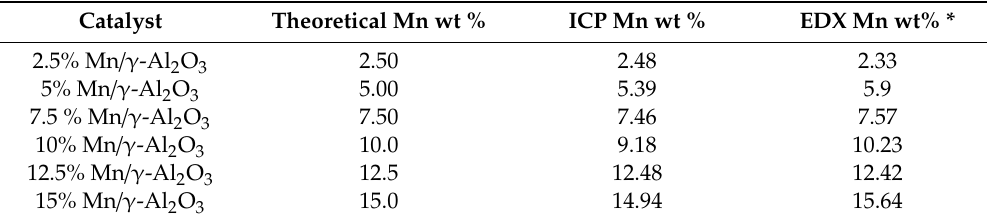
Table 1. Inductively coupled plasma (ICP) and energy dispersed X-Ray spectroscopy (EDX) results of Mn/γ-Al 2 O 3 catalysts.